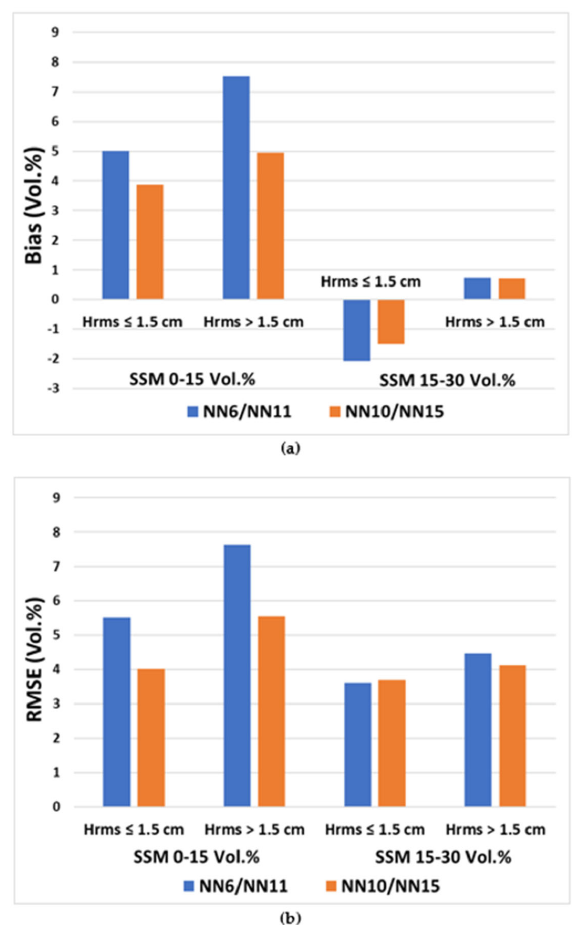
Figure 12. Calculated error on the retrieved SSM using C ‐ band real SAR data versus in situ measurements. The inversion was performed using a priori information on SSM without using Hrms in the input vector (NN6/NN11) and with noisy Hrms in the input vector (NN9/NN14). ( a ) Bias (estimated SSM − in situ SSM); ( b ) RMSE.